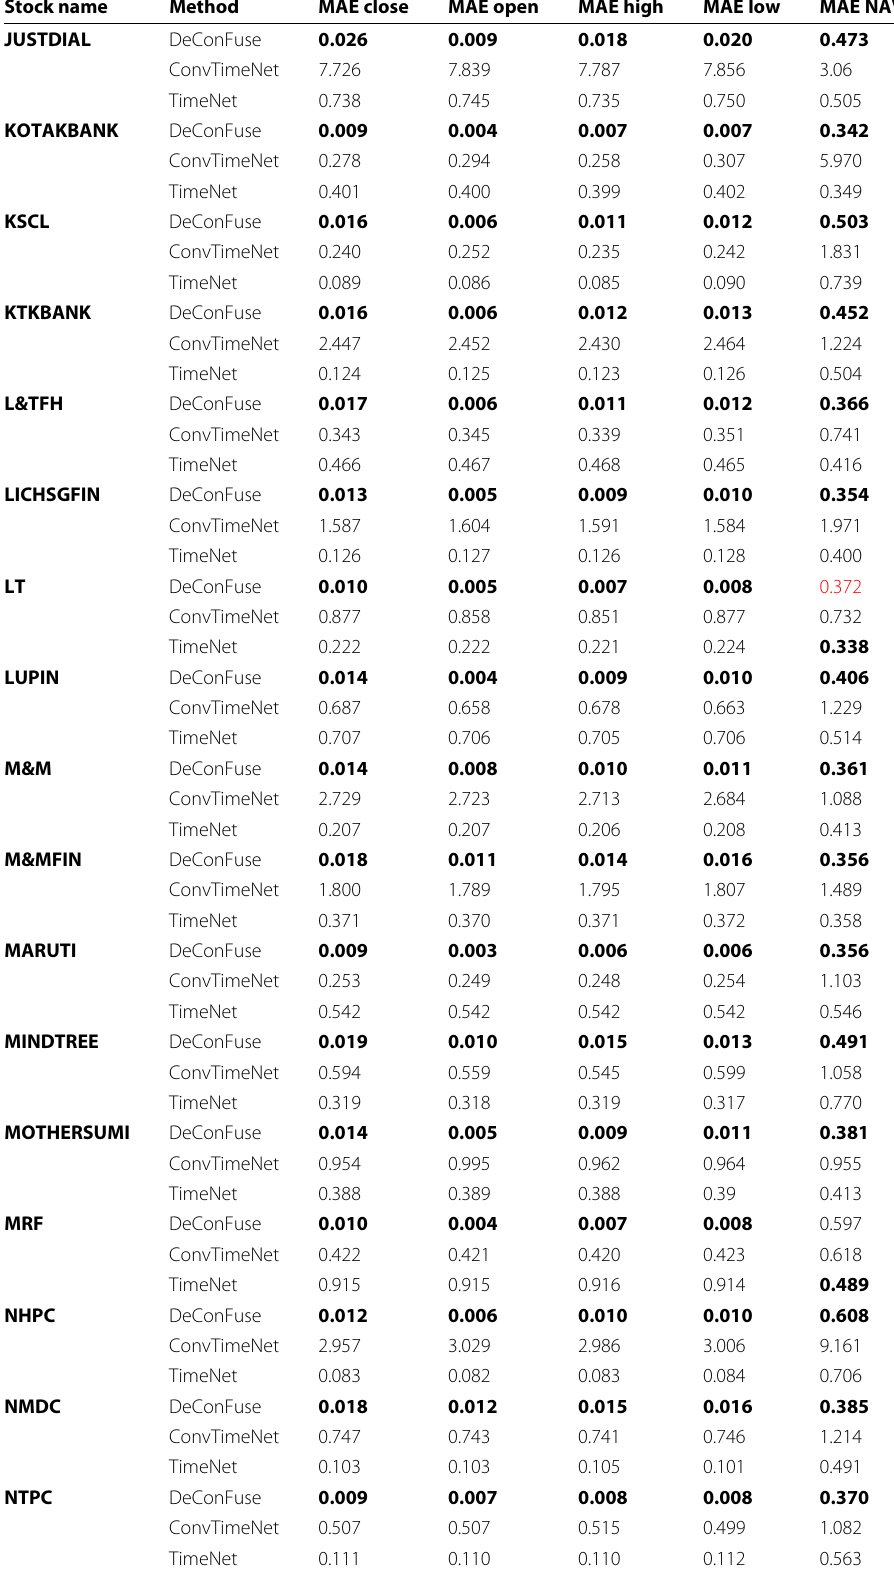
Table 5 Stock-wise forecasting results ( Continued